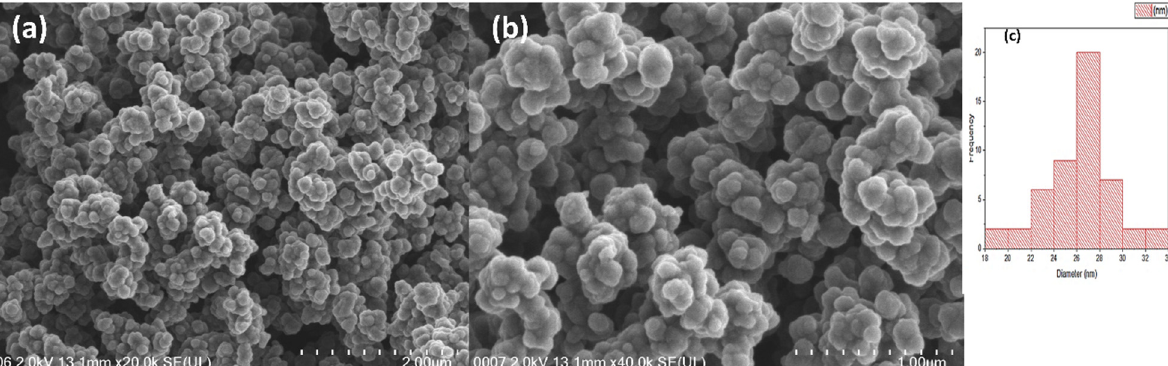
Figure 7. FE ‐ SEM micrograph of PPy ‐ PEI Nano adsorbent at different magnifications for adsorption Figure 7. FE-SEM micrograph of PPy-PEI Nano adsorbent ( a ) before adsorption, ( b ) after adsorption of lead ions. ( a ) the PPy ‐ PEI before adsorption; ( b ) the PPy ‐ PEI after adsorption with the metal ion; and ( c ) histogram showing frequency distribution of particle sizes of adsorption of lead ( c ) The polypyrrole ‐ polythelimine adsorbent’s range.